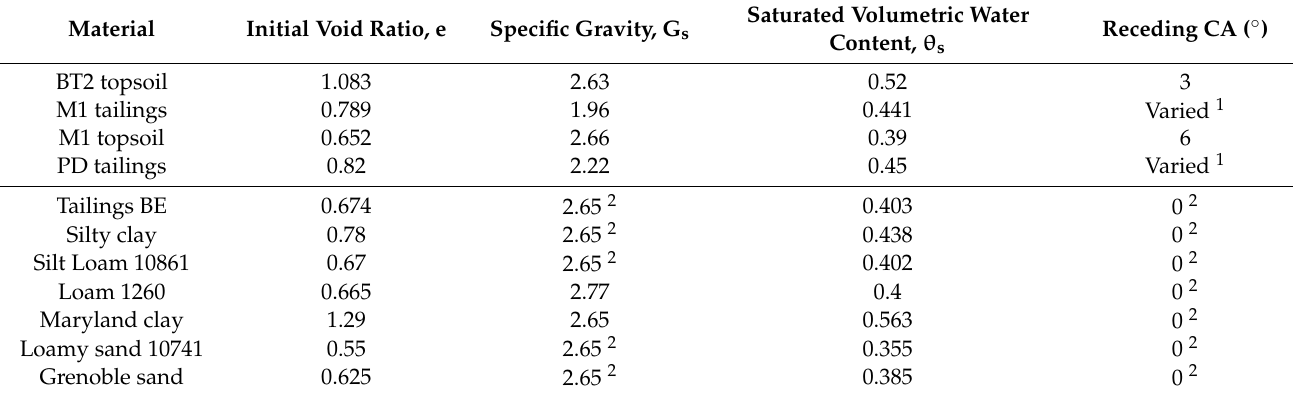
Table A6. Parameters used in the non-similar-media-concept model (NSMC) for each material: initial void ratio, specific gravity, saturated volumetric water content ( θ s ), and receding contact angle (CA).